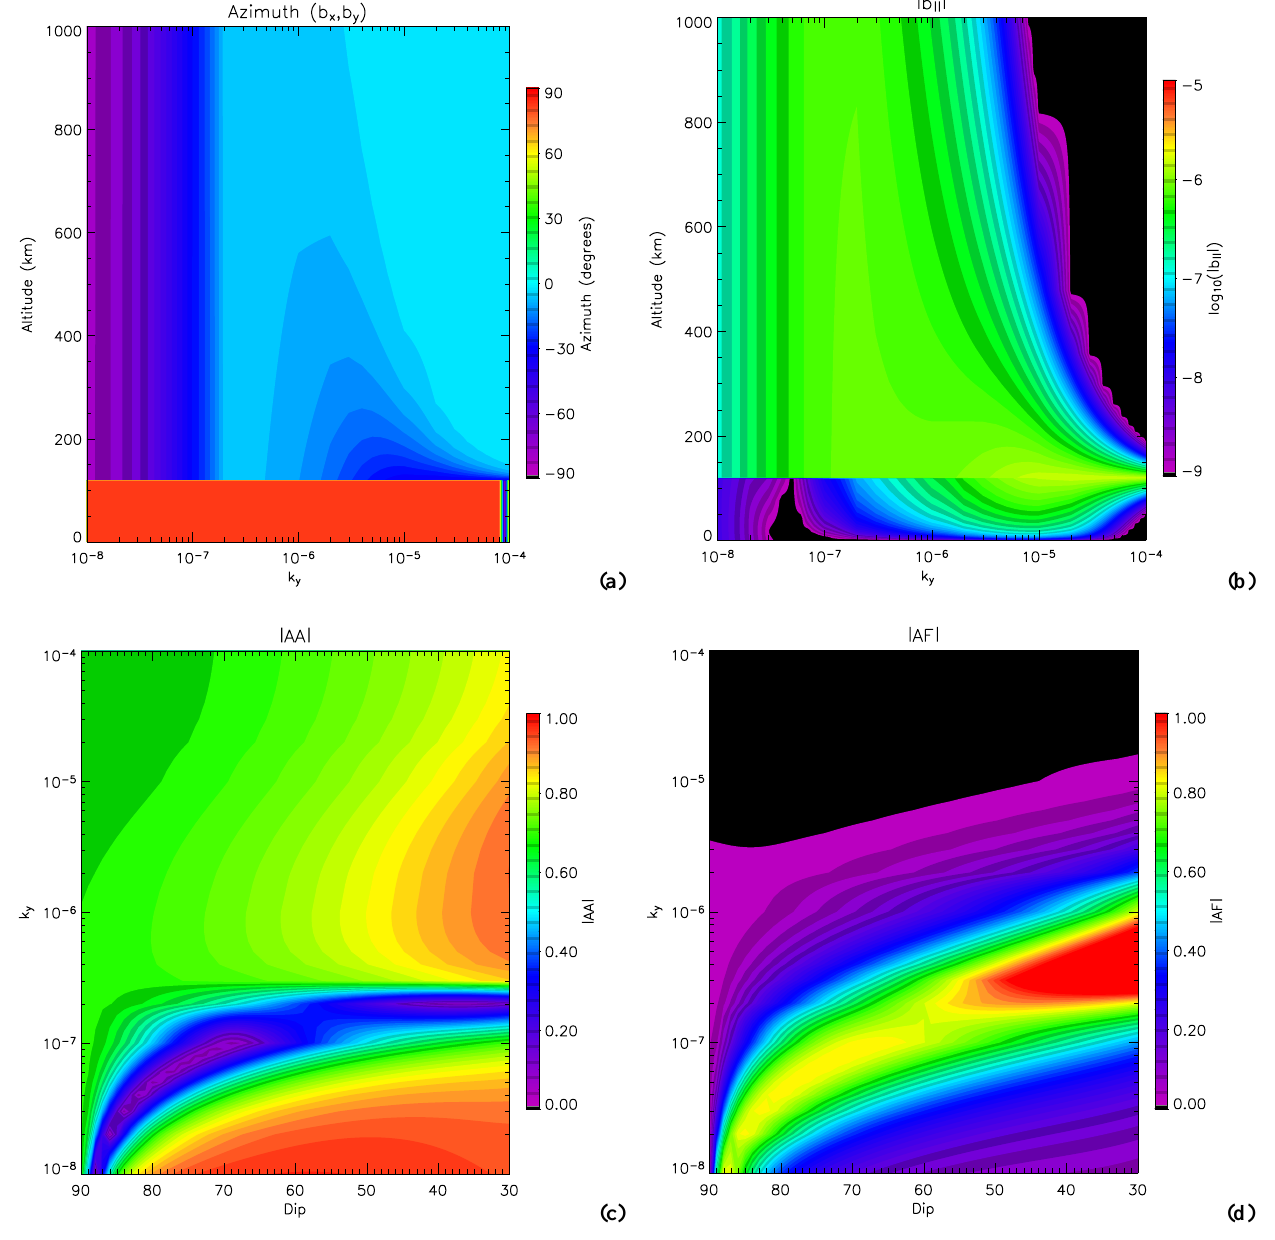
Fig. 7. Results from the analytical model of Sciffer et al. (2004). The parameters used were: V a = 6 . 4 × 10 5 ms − 1 , k x =1 × 10 − 10 m − 1 and k y varying between 10 − 8 m − 1 and 10 − 4 m − 1 . The current sheet altitude was d=120km and the frequency, 16mHz. The height integrated conductivities were 6 0 = 10 6 S, 6 p = 6 . 2S and 6 h = 7 . 6S. (a) Polarisation azimuth rotation ( b x , b y ) for dip, I = 70 ◦ . (b) Amplitude of the field aligned (compressional) component of the ULF wave for dip, I = 70 ◦ . (c) Absolute value of the reflection ratio, AA versus k y and dip angle. (d) Same as (c) but for the conversion coefficient, AF (shear Alfv´en to compressional wave